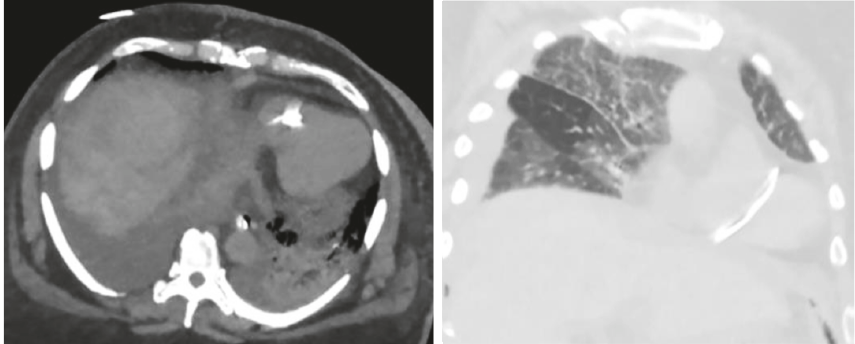
Figure 3: CT chest showing the fractured catheter in the right ventricle.